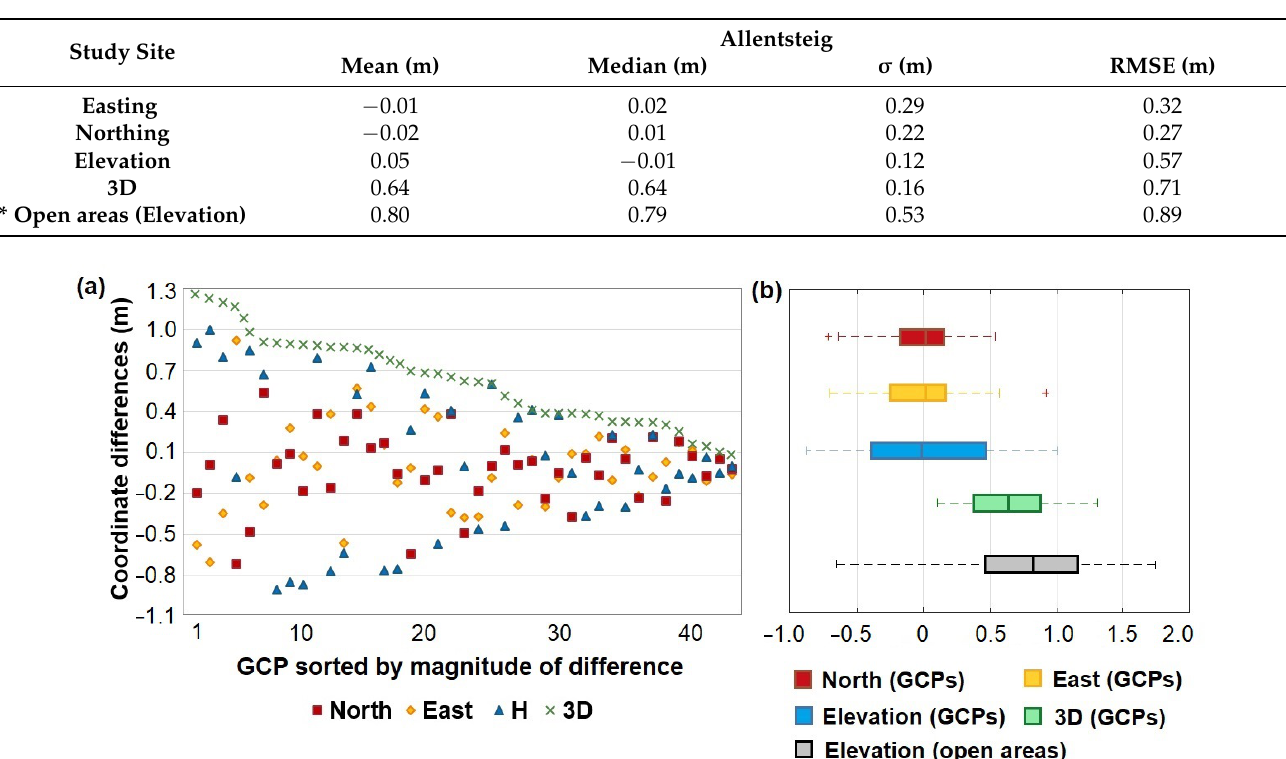
Table 3. Accuracy statistics at 43 GCPs’ coordinates and on elevation for open areas (* Vertical accuracy of Pléiades DSM against Lidar DTM in open, object-free areas).